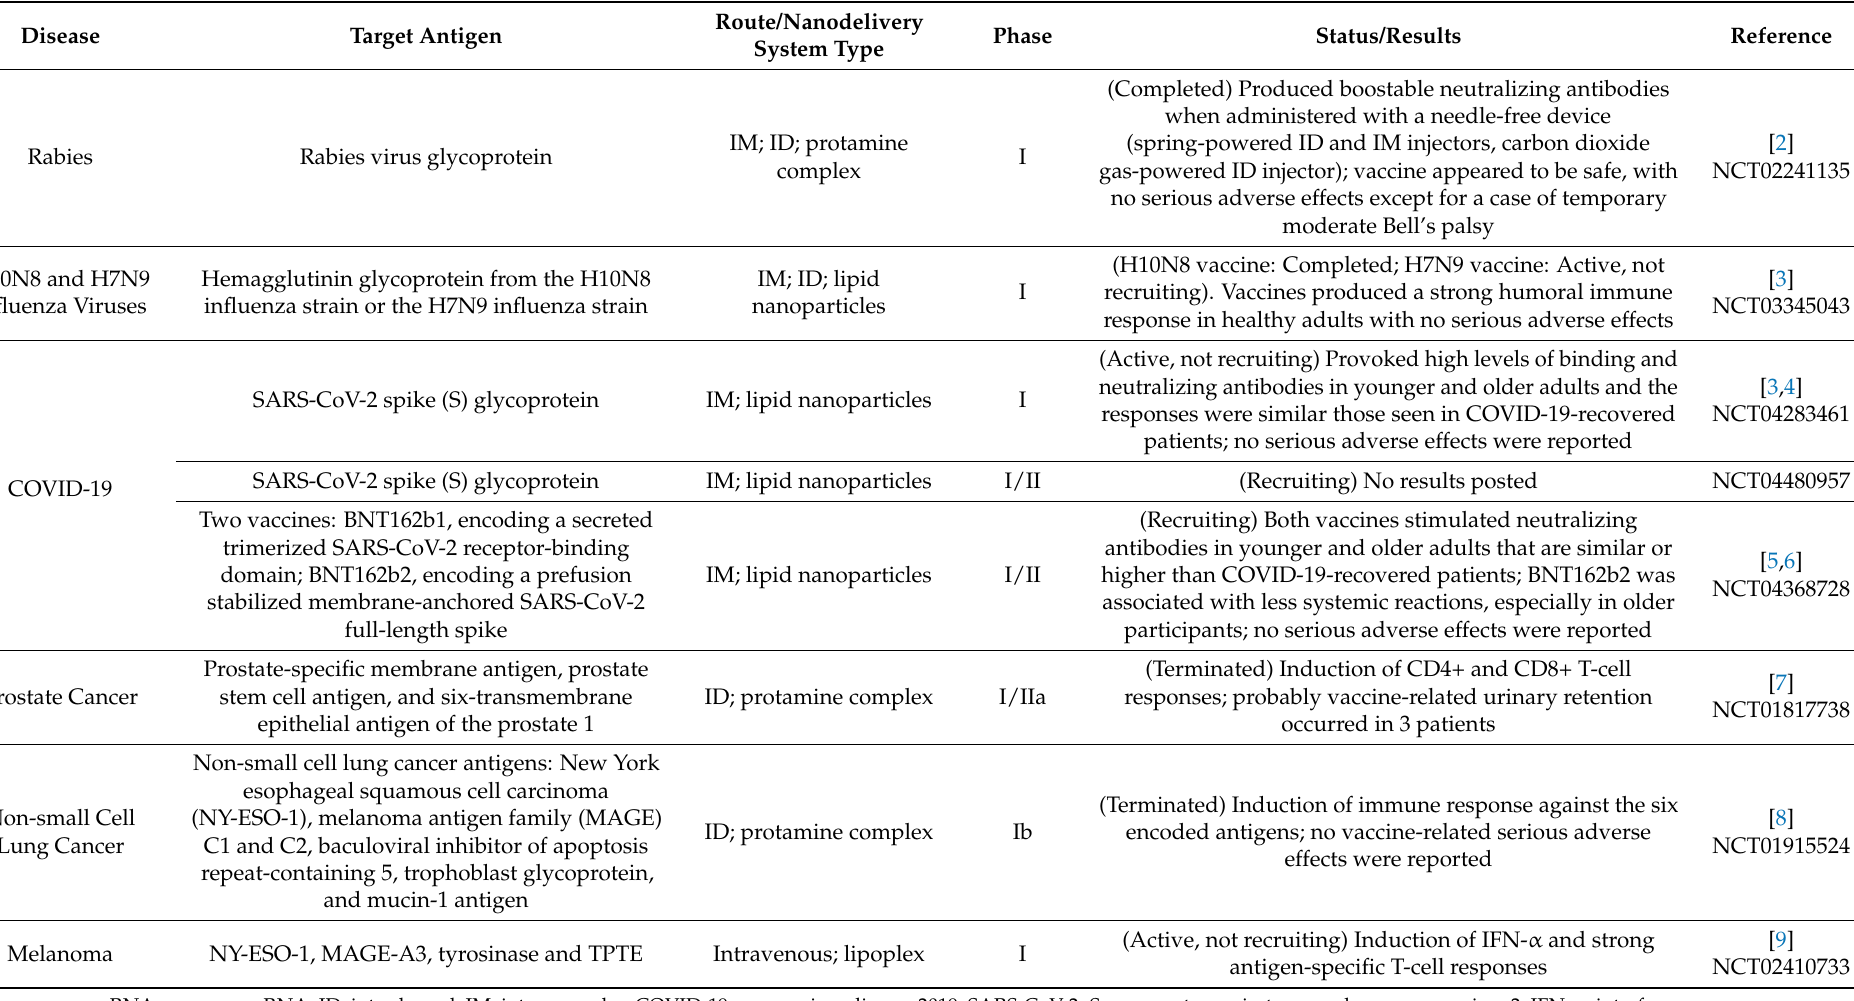
Table 1. Examples of clinical trials using nanodelivery systems for mRNA-based